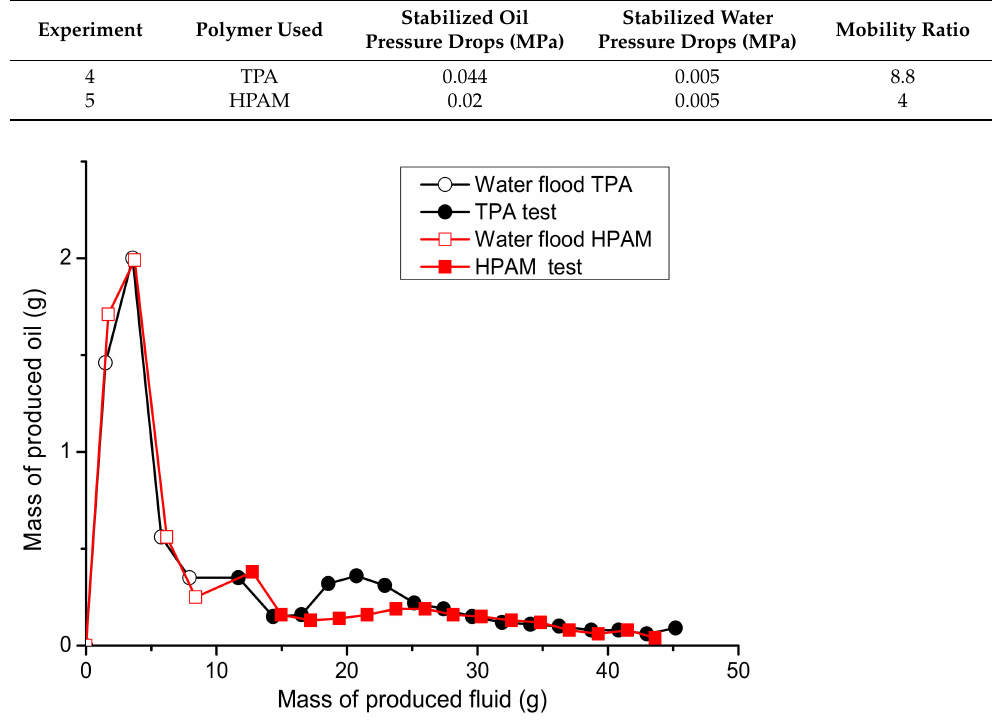
Figure 12. Mass of oil produced during water and polymer injections into the sand-pack models during experiments 3 and